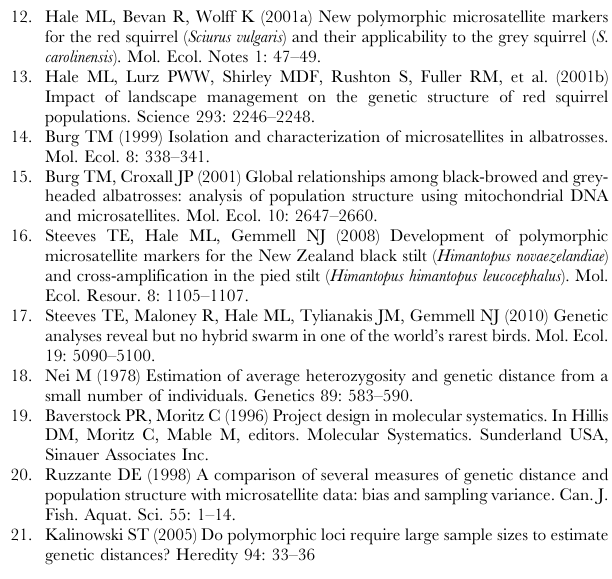
Table S1 Allele frequencies at each locus for each dataset. Ants ( Formica lugubris , n = 547); squirrels ( Sciurus vulgaris , n = 107), albatross ( Thalassarche melanophris , n =616), and kakı¯ ( Himantopus novaezelandiae , n =98). Both the albatross and kakı ¯ dataset contained missing data for some loci, number of individuals genotyped at each locus is indicated below locus name. There were no missing data in the ant and squirrel